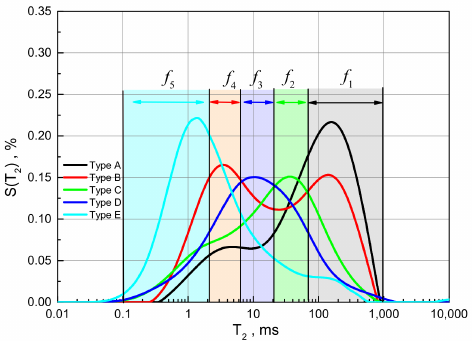
Figure 8. Corresponding relationship between T 2 spectra and pore space.